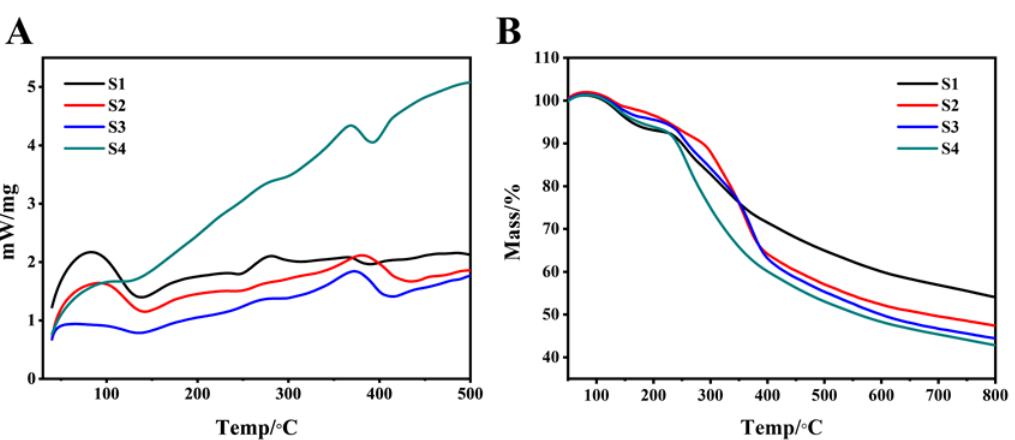
Figure 4. S1 – S4 comprehensive thermal analysis spectrum. ( A ): S1 – S4 DSC curve; ( B ): S1 – S4 Tg Figure 4. S1–S4 comprehensive thermal analysis spectrum. ( A ): S1–S4 DSC curve; ( B ): S1–S4 Tg curve. curve. Table 3. The weightlessness of the samples at different temperatures.